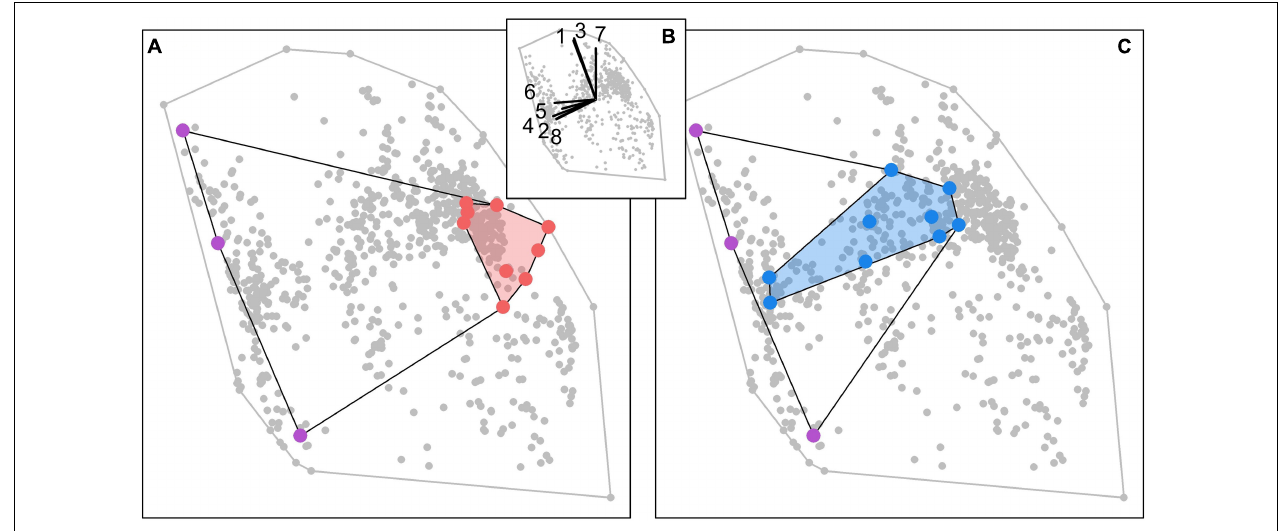
FIGURE 8 | Illustration of resilience enhancement of two coral communities (red and blue polygons) by adding three species (purple dots) that have complex morphologies but different bleaching susceptibilities, growth rates and modes of larval development. Adding the competitive species to the non-resilient community (A) increases its overall resilience via the dominance effect, while adding them to the resilient community (C) enhances its resilience via the insurance effect. Gray dots show the location of all the 798 coral species in the functional space. The traits defining the functional space in panel (B) are: (1) bleaching susceptibility; (2) colony complexity; (3) colony maximum diameter; (4) dislodgement susceptibility; (5) colony fecundity; (6) growth rate; (7) mode of larval development; (8) overtop capacity.